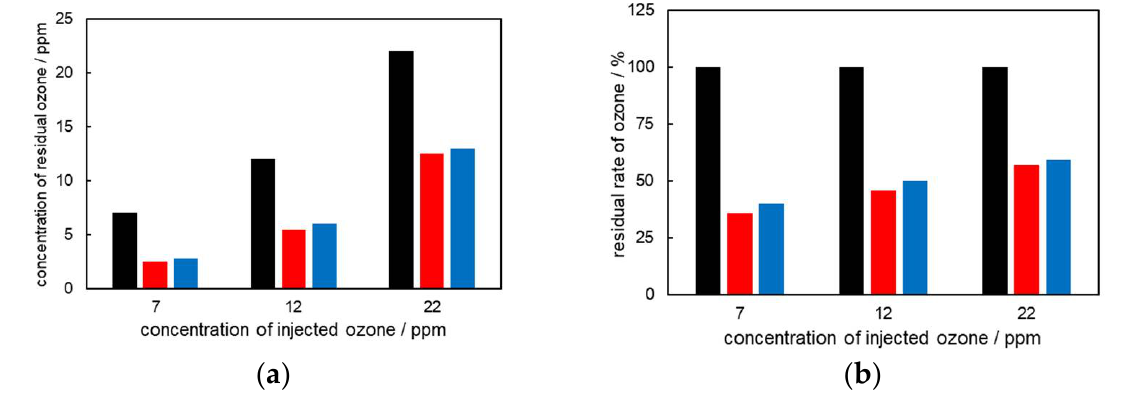
Figure 3. ( a ) Residual ozone concentration, ( b ) residual rate of ozone under each condition (black: without reaction, red: with UV irradiation, blue: without UV irradiation).